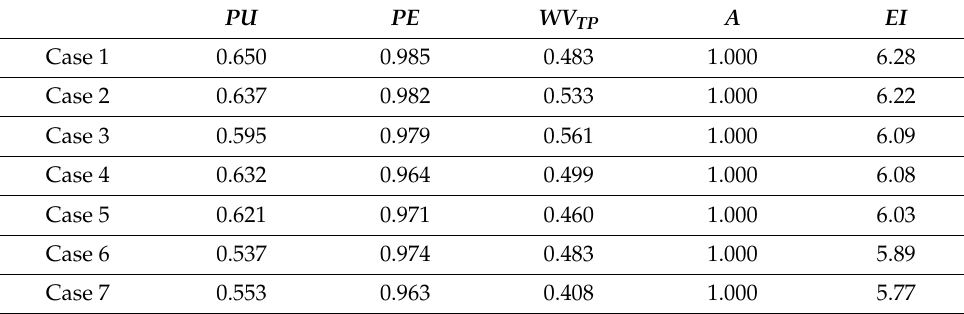
Table 5. Types of waste sorting on individual workstations. PU PE WV